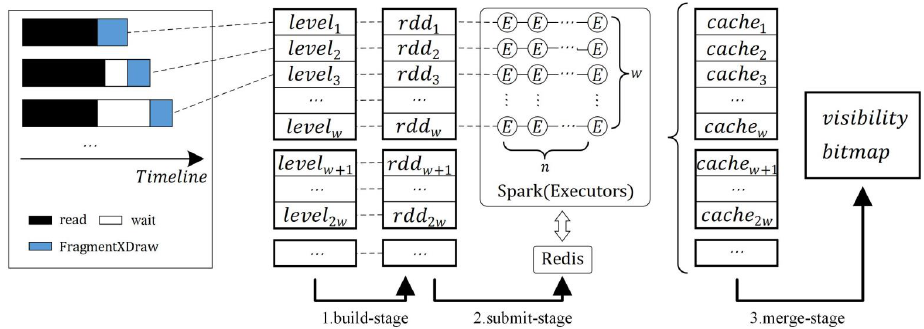
Figure 8. The detail of Spark-based ML-XDraw, which submits multiple RDD tasks